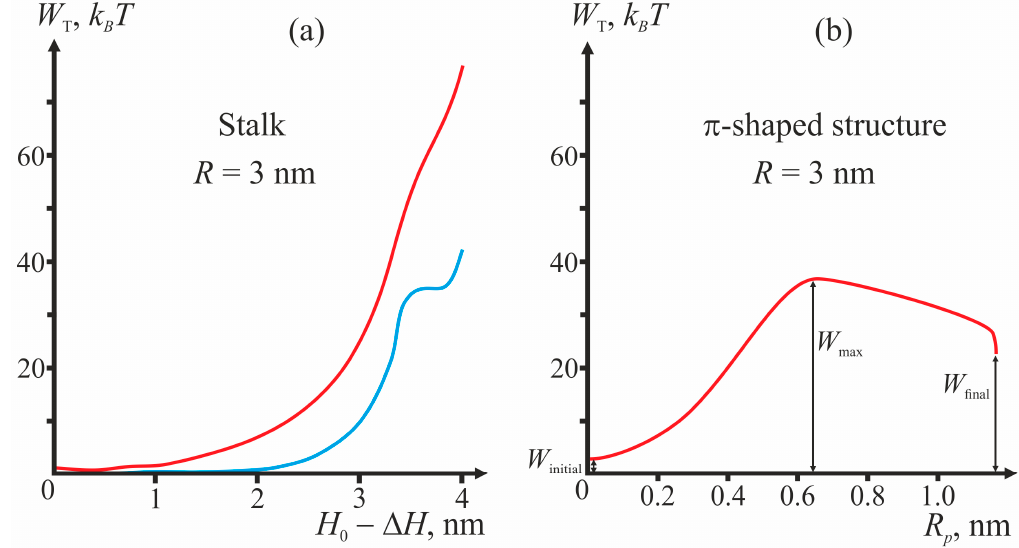
Figure 3. Dependence of the total energy ( W T ) of the membrane on the process coordinates for the scenarios with formation of stalk ( a ); and π -shaped structure ( b ). The geometric parameters are as follows: the radius of fusion rosette R = 3 nm, half-width of the fusion peptide annulus R FP = 0.1 nm, shallow insertion. In the case of stalk, the red curve corresponds to the total energy W T , the blue curve—to the sum ( W h + W f ), i.e., the total energy less the deformation energy. For the case of π -shaped structure, only the dependence on the pore radius R p is shown; the energy is minimized with respect to the hydrophobic belt height L for each fixed R p .